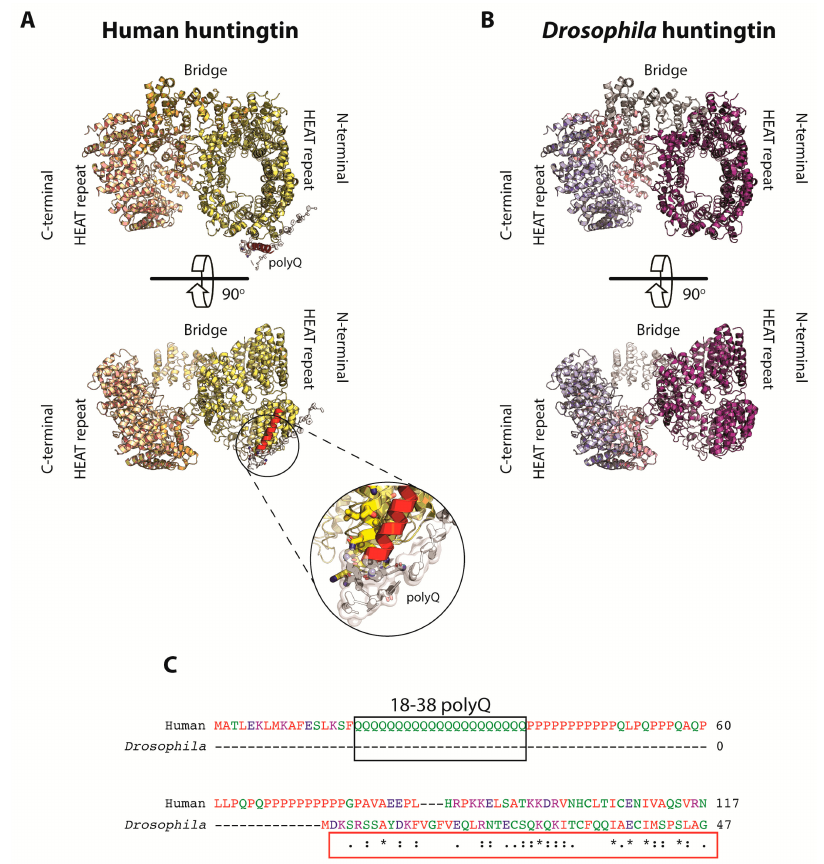
Figure 2. Comparison between Homo sapiens and Drosophila melanogaster huntingtin proteins. ( A ) Architecture of Homo sapiens HTT with its different domains in two different planes, with a rotation of 90 degrees on the X-axis. The N-terminal domain begins with an α -helix continued for a stretch of polyglutamines/polyprolines not present in the homologous version of this protein in Drosophila melanogaster . Such a domain is zoomed in to highlight its key role and interaction with the rest of the protein for the development of HD. HEAT repeats domains are represented by C-terminal (ochre), bridge (yellow) and N-terminal (pale yellow). ( B ) Architecture of Drosophila melanogaster htt showing its different domains in two different planes, represented in the same way as the Homo sapiens homologous version. HEAT repeats domains are represented by C-terminal (purple blue), bridge (purple violet) and N-terminal (purple deep). ( C ) Alignment of the first part of the N-terminal domain of the Homo sapiens and Drosophila melanogaster huntingtin protein sequences, identifying the polyglutamine stretch as relevant for HD development in the Homo sapiens sequence but not in the Drosophila melanogaster sequence. The figure was created using the Protein Data Bank entries 3io4 and 6ez8 [20,81]. An asterisk ( * ) indicates positions which have a single, fully conserved residue. A colon ( : ) indicates conservation between groups of strongly similar properties. A period ( . ) indicates conservation between groups of weakly similar